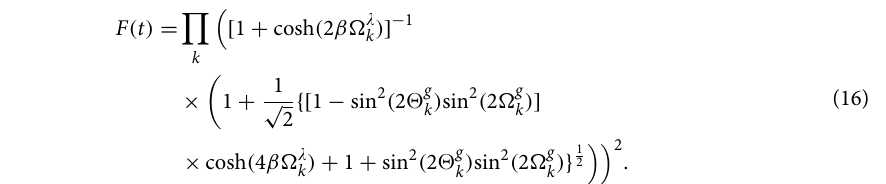
1 , γ 0.05 , 1 , and δ = = =